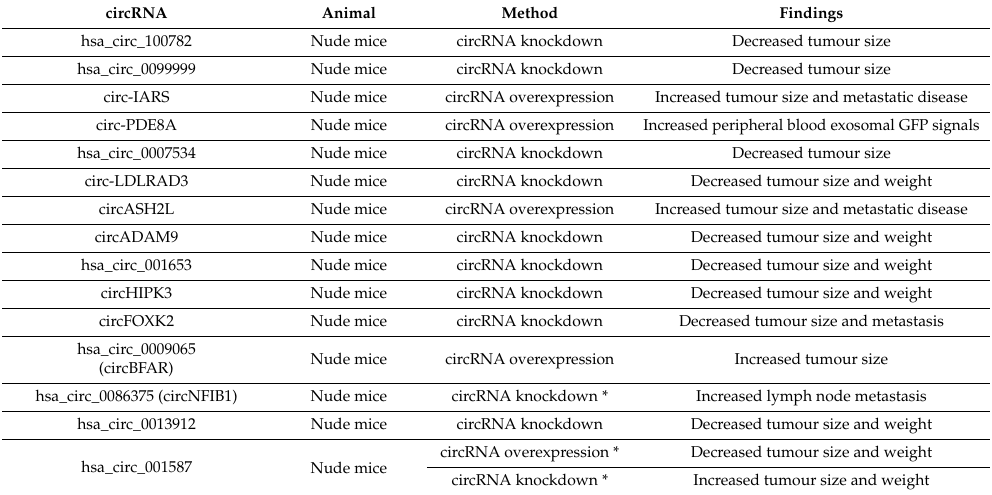
Table 4. Function of circRNAs in PDAC identified in animal studies. * All circRNAs were upregulated in PDAC, except for hsa_circ_0086375 (circNFIB1) and hsa_circ_001587, which were